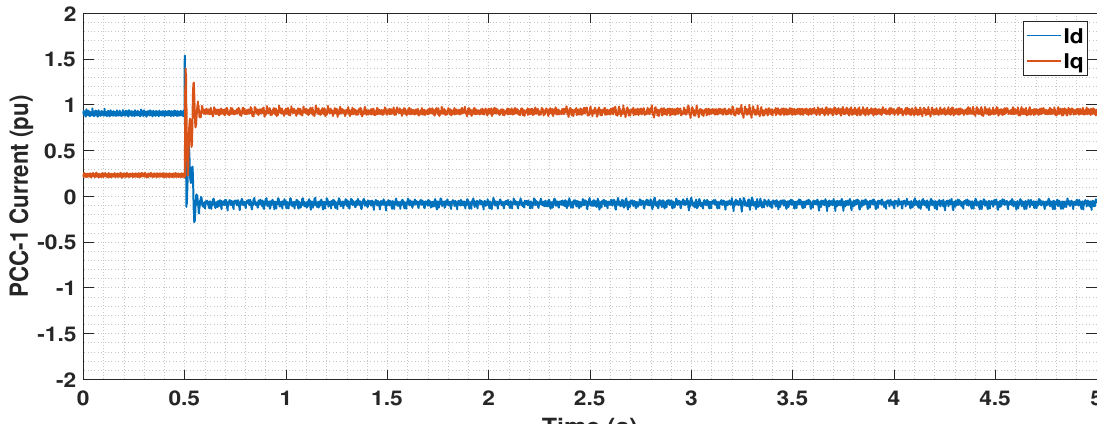
Figure 39. Currents in d and q axes in PCC-1 upon three-phase line to ground fault in the middle of